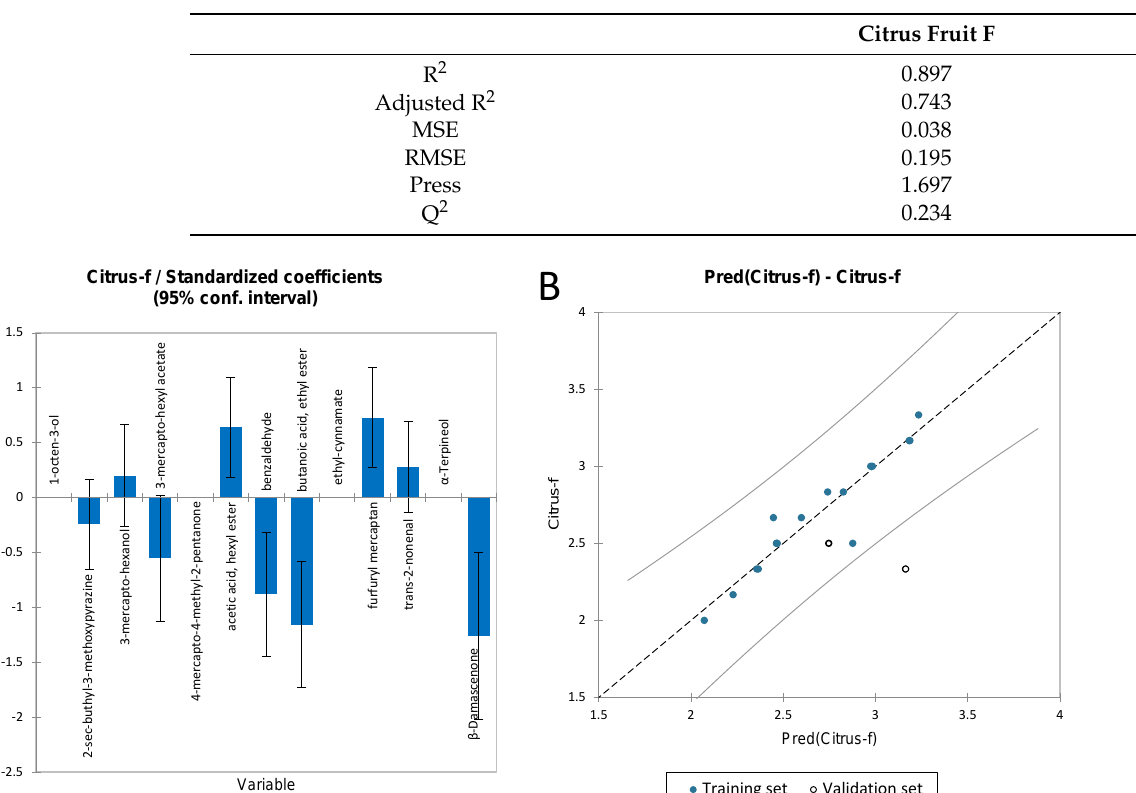
Table 9. Quality index for MLR on Sauvignon Blanc data.